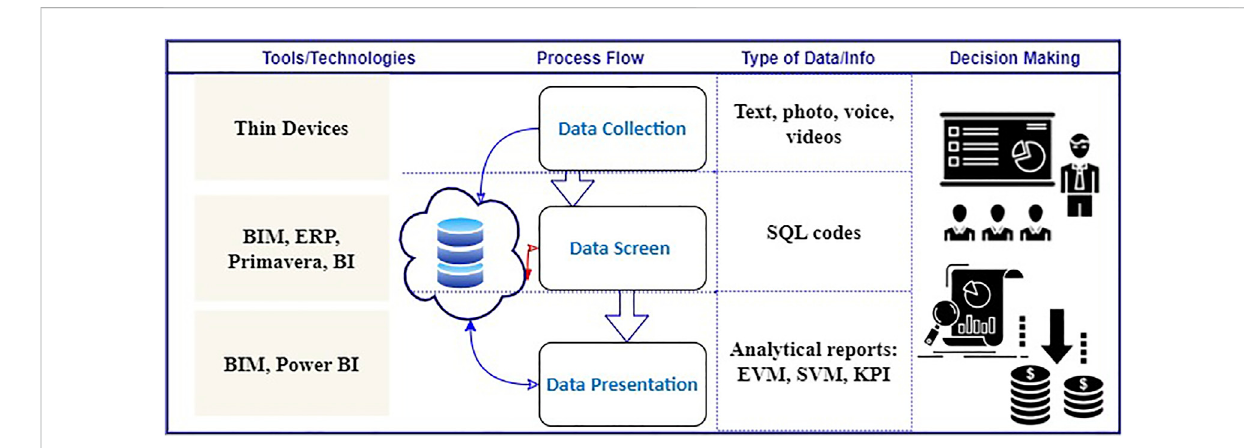
FIGURE 4 The proposed framework.